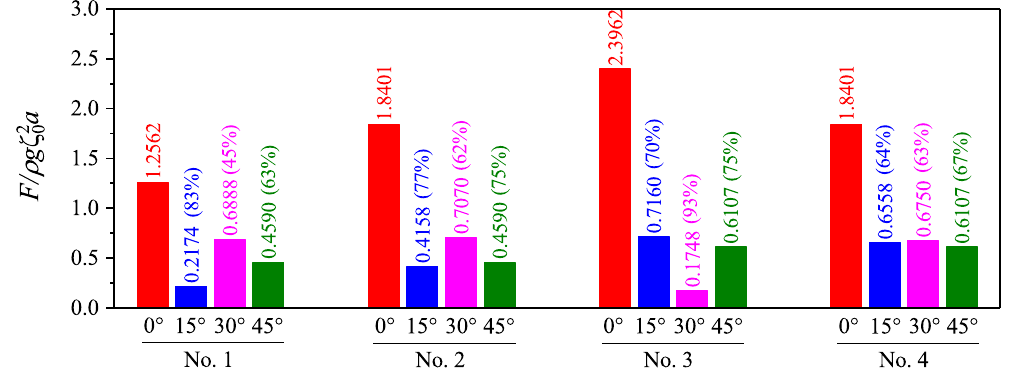
Figure 11. The wave drift forces on each cylinder against four different wave-approach angles and the corresponding decrement percentage at k 0 a =